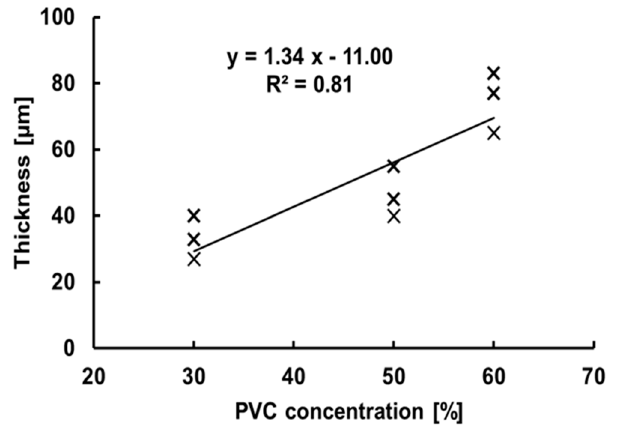
Figure 6. Relationship between the concentration of PVC solution and thickness of fabricated artificial trabecular meshwork.